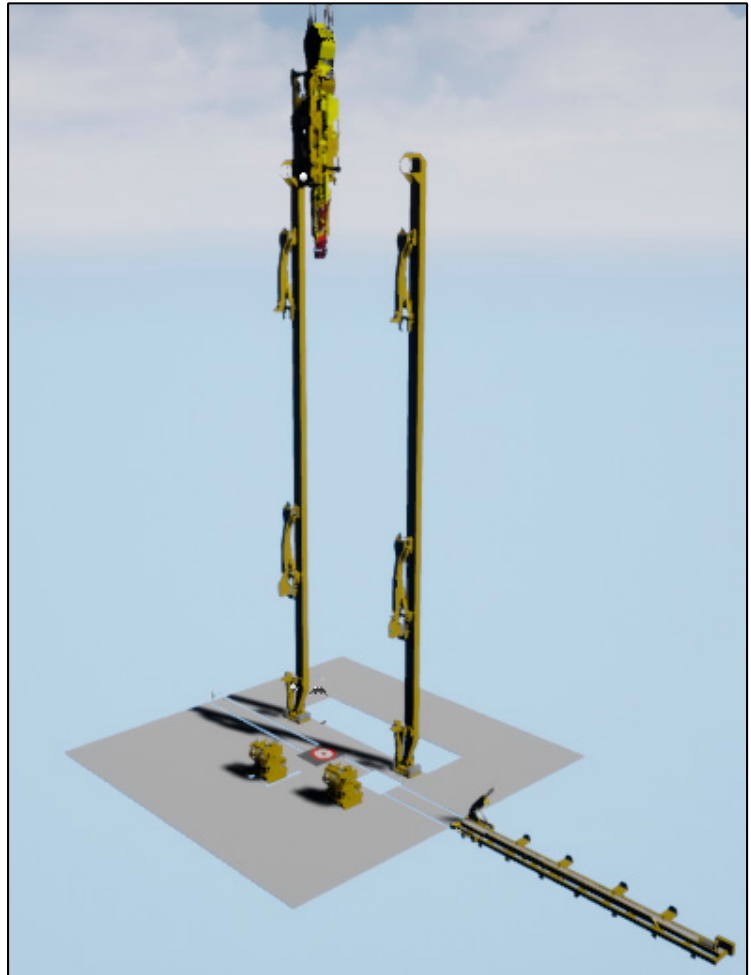
Figure 10. The visualization of the drilling floor in Unreal Engine 4.